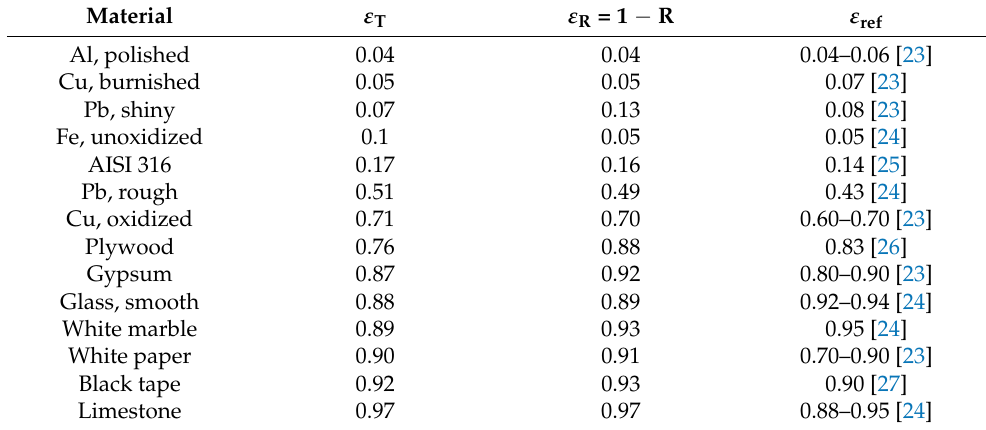
Table 1. Emissivity of various material samples, as measured according to the direct ( ε T ) and indirect ( ε R ) method, respectively, and corresponding literature data ( ε ref ).